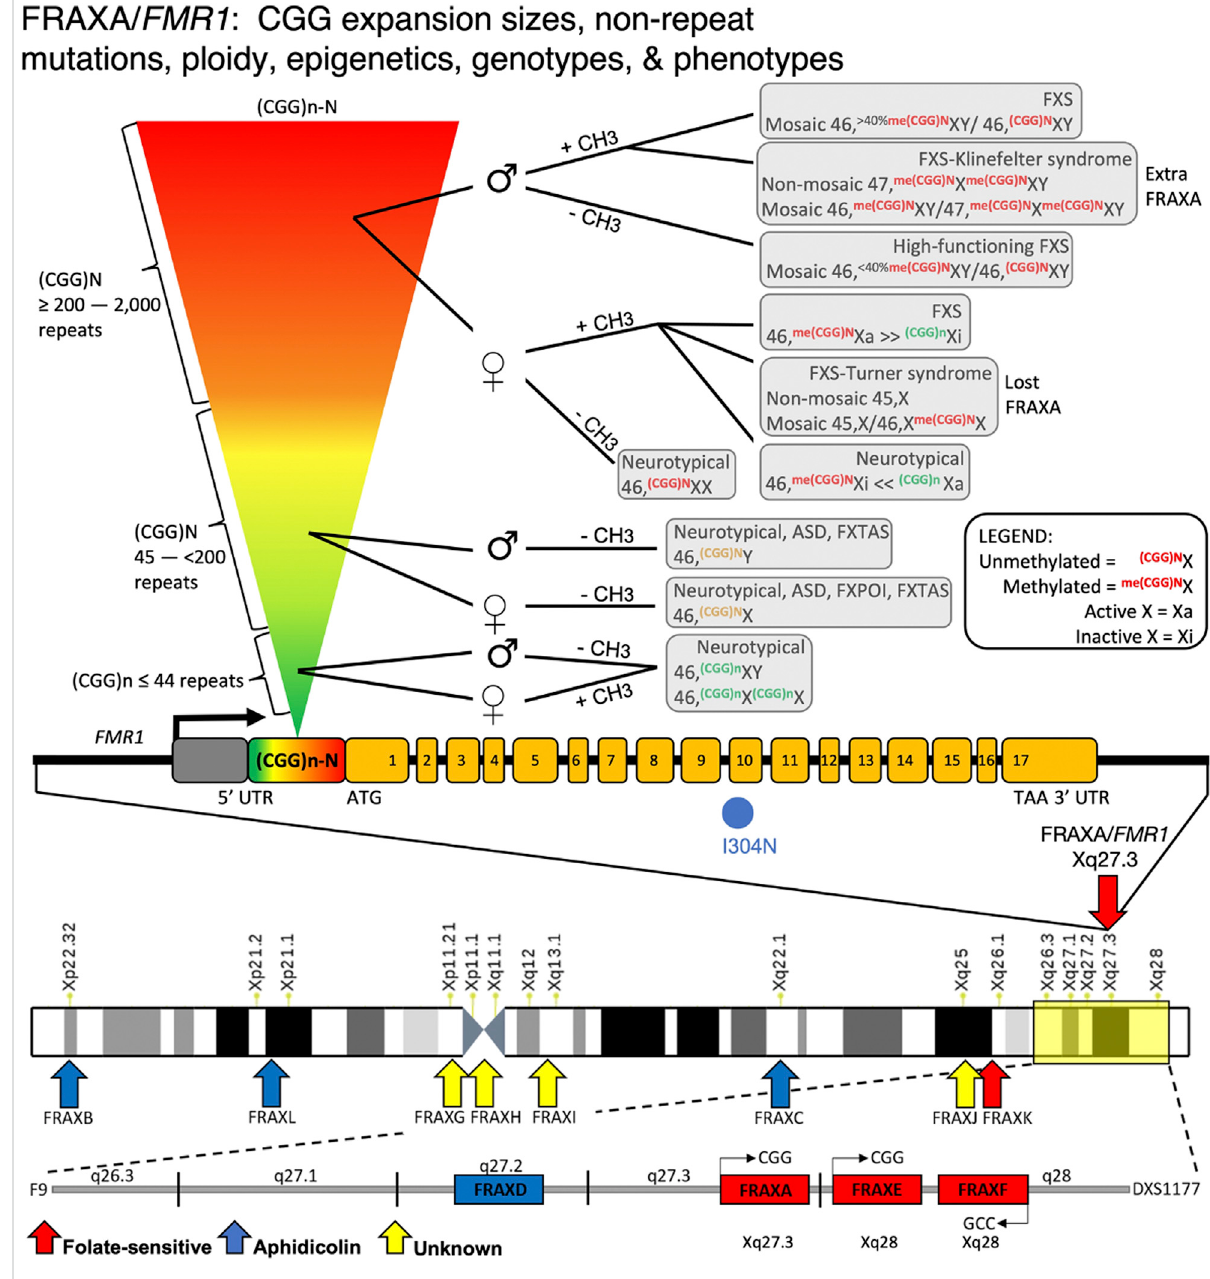
FIGURE 5 FMR1/ FRAXA numerous mutations, genotypes, and phenotypes. Disease mosaicism reported at the FMR1 (CGG)n repeat locus, in fl uenced by repeat size (rainbow inverted triangle showing increasing repeat size), DNA methylation of the repeat expansion ( ± CH3), and sex of patient ( _ = male; \ = female). Individuals with < 44 repeats, regardless of sex, are neurotypical. Those with repeats between 45 and 200 can have Fragile X-Associated Tremor/Ataxia Syndrome (FXTAS) or autism if male with unmethylated repeat. If female, these individuals have unmethylated alleles that are likely neurotypical or have Fragile X primary ovarian insuf fi ciency (FXPOI). With expansions > 200 repeats, the disease spectrum becomes more variable. In females, X-inactivation affects disease outcome. Due to the presence of two X alleles in females and random X-inactivation, DNA methylation effects can vary substantially between individuals depending on which allele is X-inactive (Xi) compared to active (Xa). This is also in fl uenced by which tissues are affected and what degree of mosaicism in X-inactivation exists in the patient. If allele is methylated, females can show FXS or Turner syndrome mosaicism based on which allele is Xi vs. Xa. Males with unmethylated expanded alleles are high functioningFXS.MethylatedindividualscanhaveFXSorFXSwithmosaicKlinefeltersyndrome.Manydeletionswithinthis FMR1 promoterregionhave been reported, causing FMR1 silencing and FXS